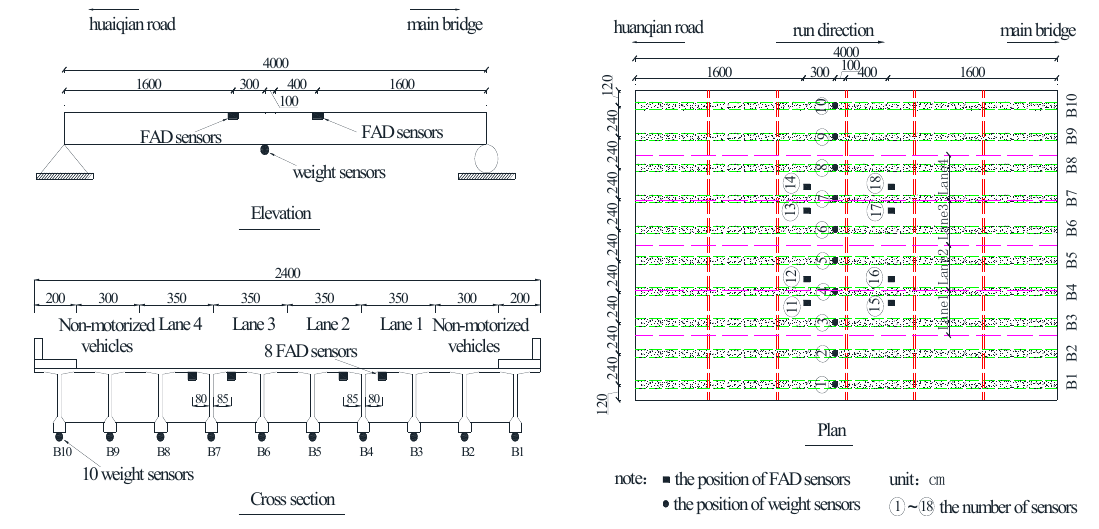
Figure 8. Wushui test bridge and sensor positions.